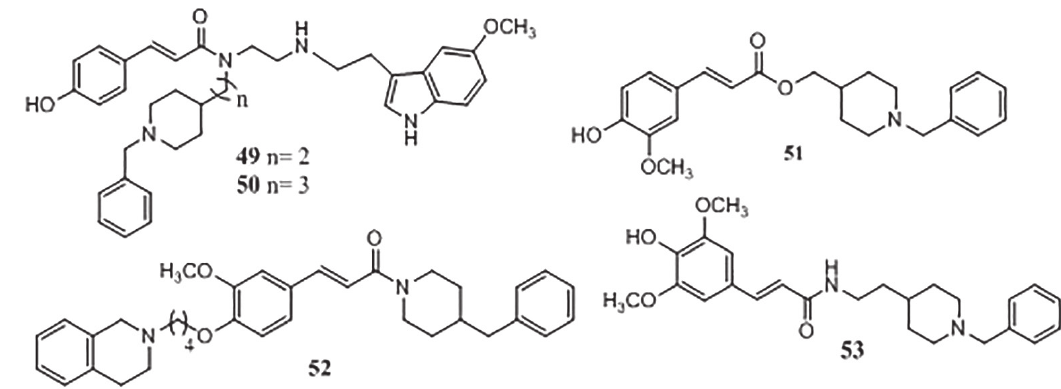
FIGURE 7 - Donepezil and ferulic acid hybrid